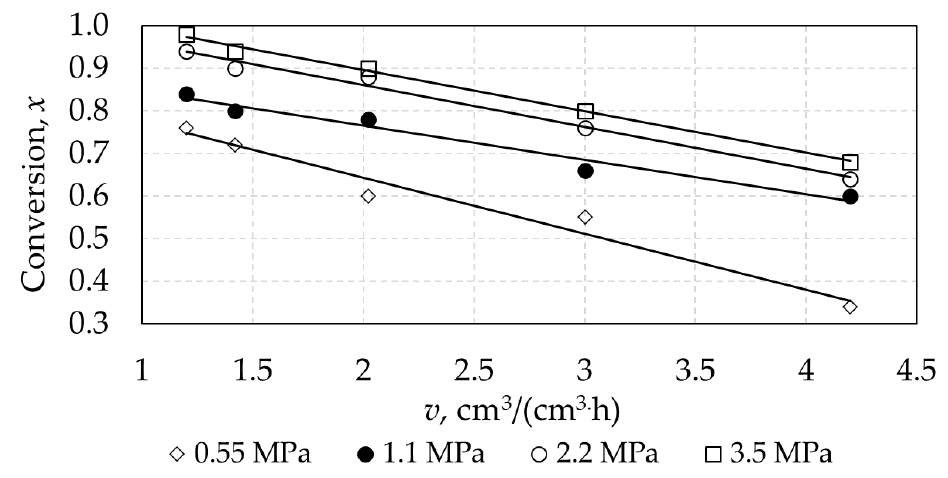
Figure 4. Dependence x = f( υ ) for different values of P .